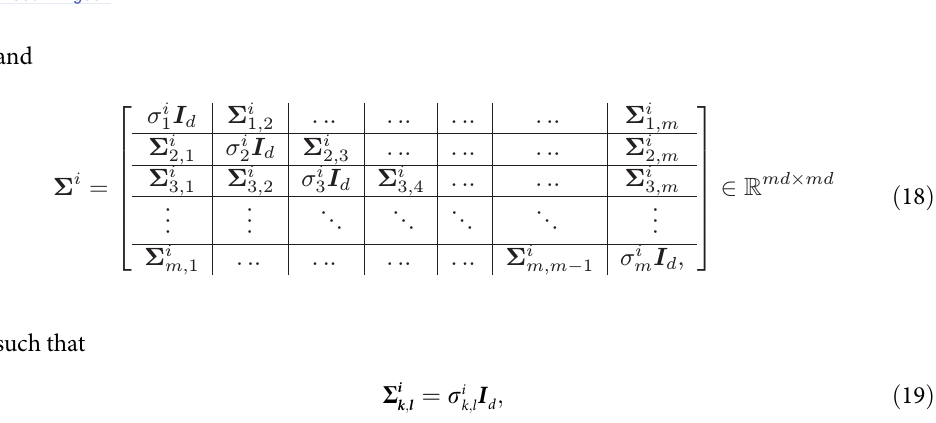
Fig 1. Illustrative diagram of the proposed method. (a) For each data point x i , we build a local graph G f f ð x Þg m . (b) We construct a random walk with transition probabilities matrix P j i j ¼ 1 SSDs of f x g n into an SSD representation matrix. (g) Subsequently, the matrix is subjected to a nonlinear dimensionality reduction using diffusion i i ¼ 1 maps by the construction of the global graph G (2) and the corresponding random walk with P (2) . (f) Via eigenvalue decomposition, we obtain a low- dimensional representation Ψ ( x i ) for i = 1, ... , n , which is used in the subsequent tasks (g).